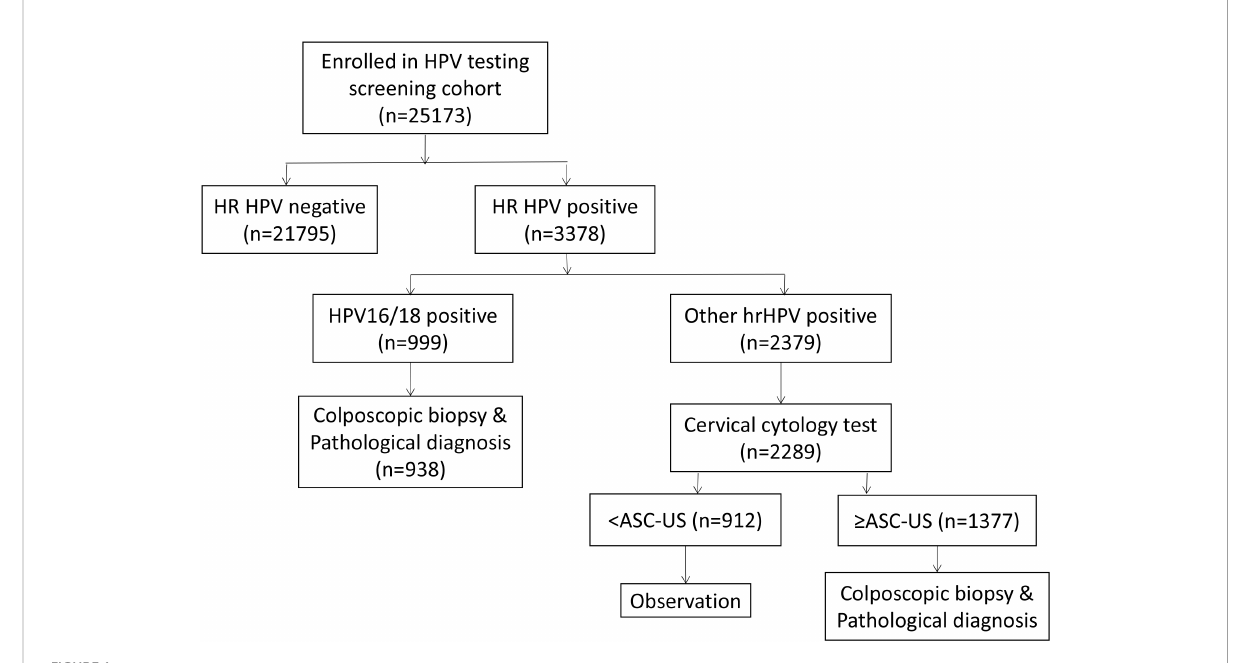
FIGURE 1 Flow of participants in the screening